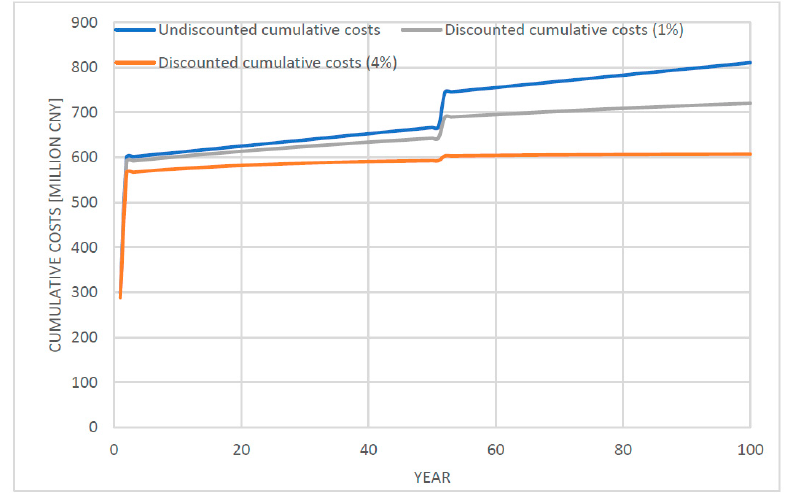
Figure 2. Undiscounted and discounted cumulative costs (net present value (NPV)).